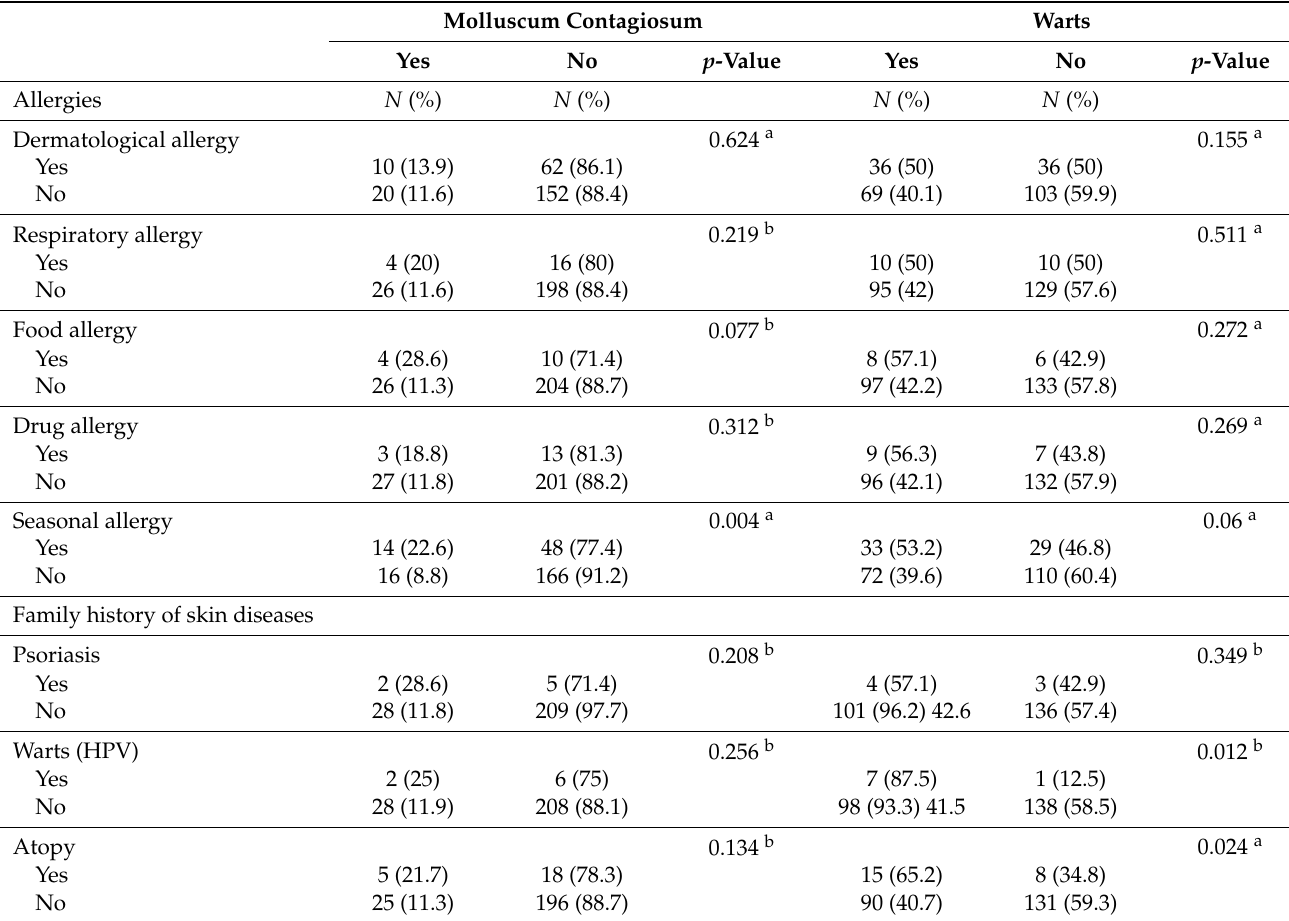
Table 2. Allergies and family history of skin diseases in relation to Molluscum Contagiosum and Warts. Molluscum Contagiosum